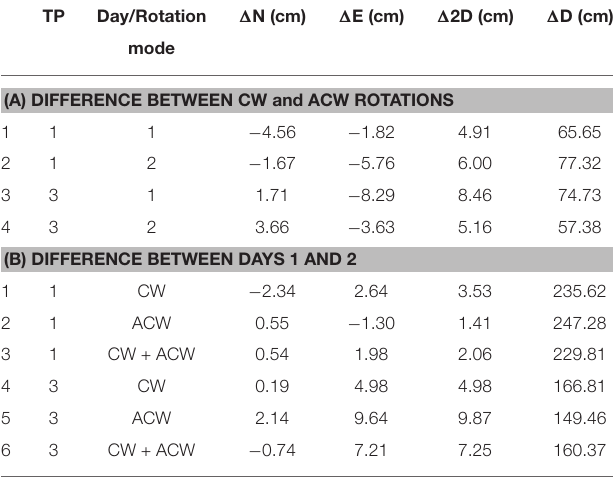
TABLE 5 | (A) Differences on East, North, and Down components between clockwise and anti-clockwise box-in rotations. (B) Differences in the East, North, and Down components between days 1 and 2 for clockwise (CW), anti-clockwise (ACW), and complete (CW + ACW) box-in